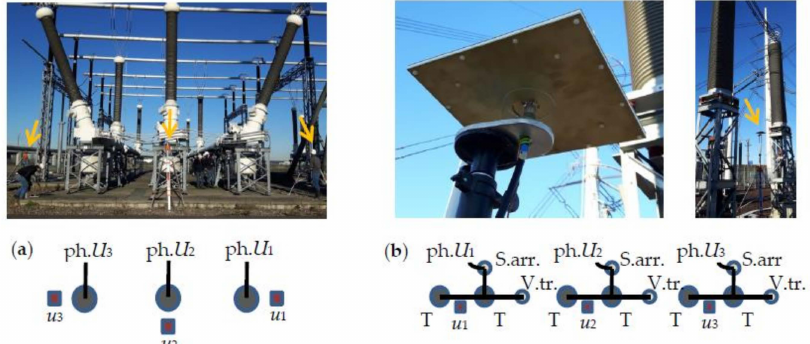
Figure 3. Topologies and sensor ( u i ) positioning with respect to phase voltages U j : ( a ) Overhead line ending at a substation, photo shows the installation of the sensors; ( b ) Overhead line to underground power cable transition (with termination T, surge arrester S.arr. and voltage transformer V.tr.), photos show the sensor (as seen from below) and its positioning in between two terminations belonging to the same phase. The sensor heights (indicated with arrows) are always chosen such, that they remain below the height reached by the supporting structures of the